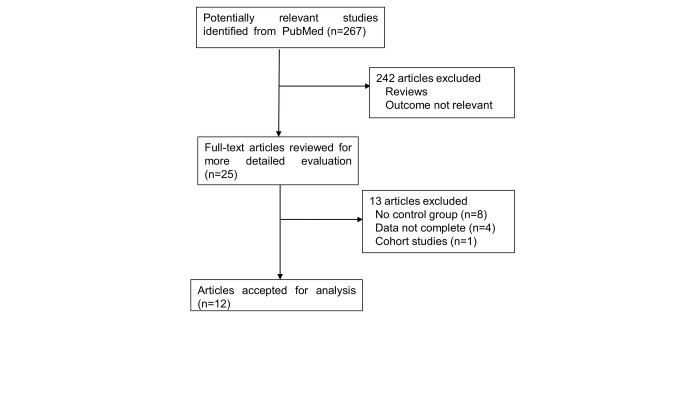
Study flow chart.